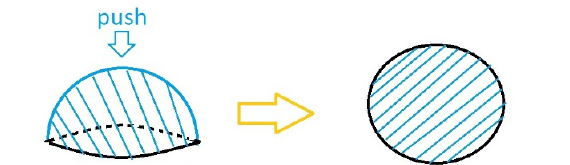
Figure 2 . Push down the bulk hemisphere onto the plane. The equator (central slice for the whole sphere or dS 3 (cid:28) = 0 time slice) on the left corresponds to the outer circle on the